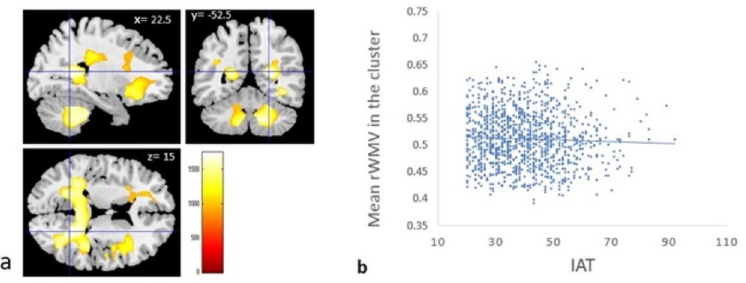
Fig 4. Regional white matter volumes correlated with internet addiction tendency (IAT) score in young adults. (a) The panels show the areas of significant negative correlation between IAT score and rWMV. The results shown were obtained using a threshold of threshold-free cluster enhancement (TFCE) of p < 0.05 based on 5,000 permutations. Significant correlations were found in the sub-gyral area of the temporal lobe, superior temporal gyrus, extra-nuclear, lentiform nucleus, right cerebellum anterior lobe, cerebellar tonsil, right inferior frontal gyrus, sub-gyral of frontal lobe, and pons. (b) Scatterplot of the association between IAT score and mean rWMV values of the largest cluster. The simple correlation coefficient between mean rWMV signal of the significant cluster and IAT score is − 0.045. The association may look weak, but the partial correlation coefficient of this association when age, sex, and total intracranial volume were accounted for is − 0.108. IAT is negatively correlated with the mean rWMV of the significant cluster 1 (r = -0.113, p = 0.003), significant cluster 2 (r = − 0.108, p = 0.005), and significant cluster 3 (r = -0.119, p = 0.002) in men. In addition, IAT has a slight negative correlation with the mean rWMV in cluster 1 (-0.104, p = 0.021) in